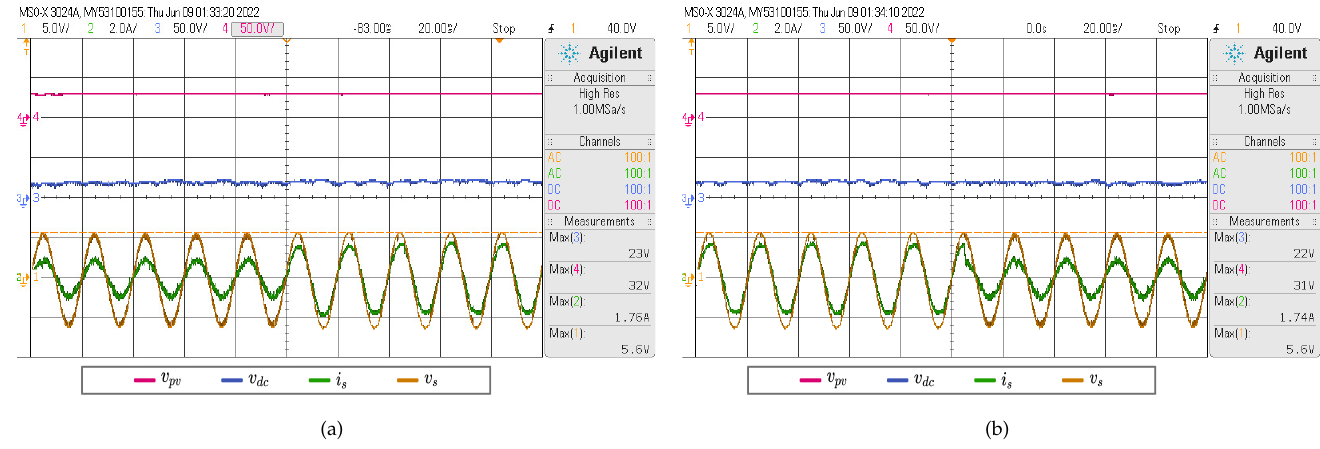
Figure 4. ( a ) Control response with an increase in reference current, ( b ) control response with a decrease in reference